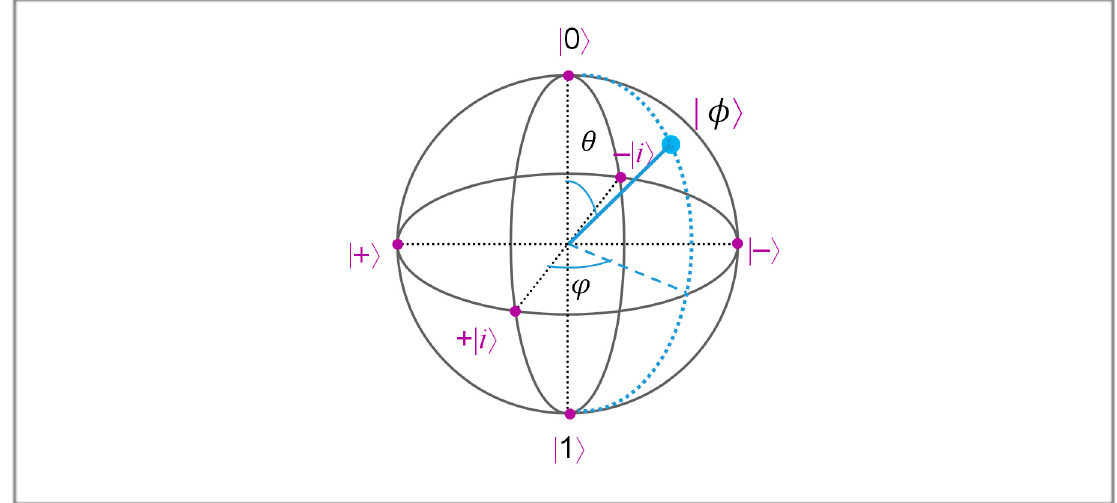
Figure 1. Bloch sphere with the qubit state |(cid:2038)(cid:1767) characterized by the angles (cid:2016) and (cid:2030)